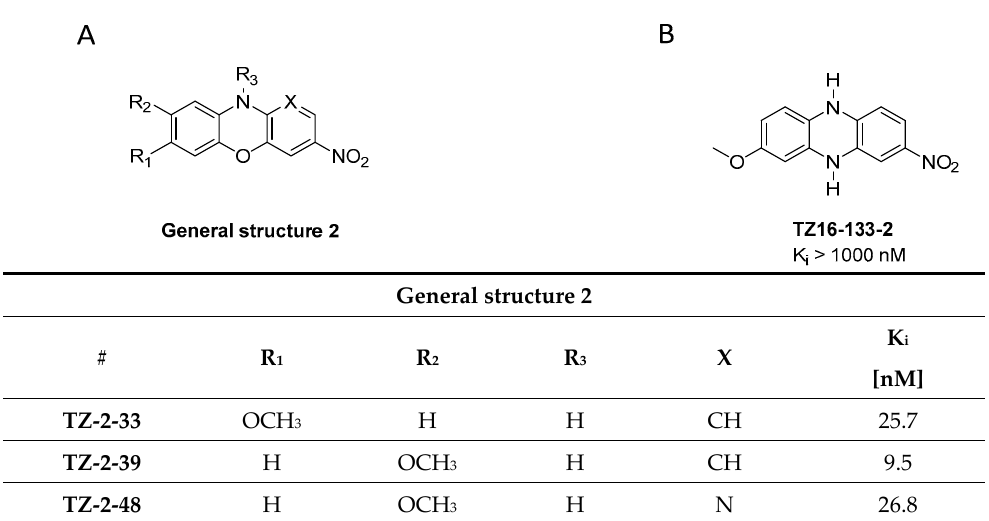
Figure 8. General structure of phenoxazine and phenazine analogues. ( A ) Chemical structure of phenoxazine analogues with binding properties utilized from ThT fluorescence assay using α -syn fibrils [97]. ( B ) Chemical structure of phenazine analogues TZ16-133-2 with binding affinity K i > 1000 nM [97].